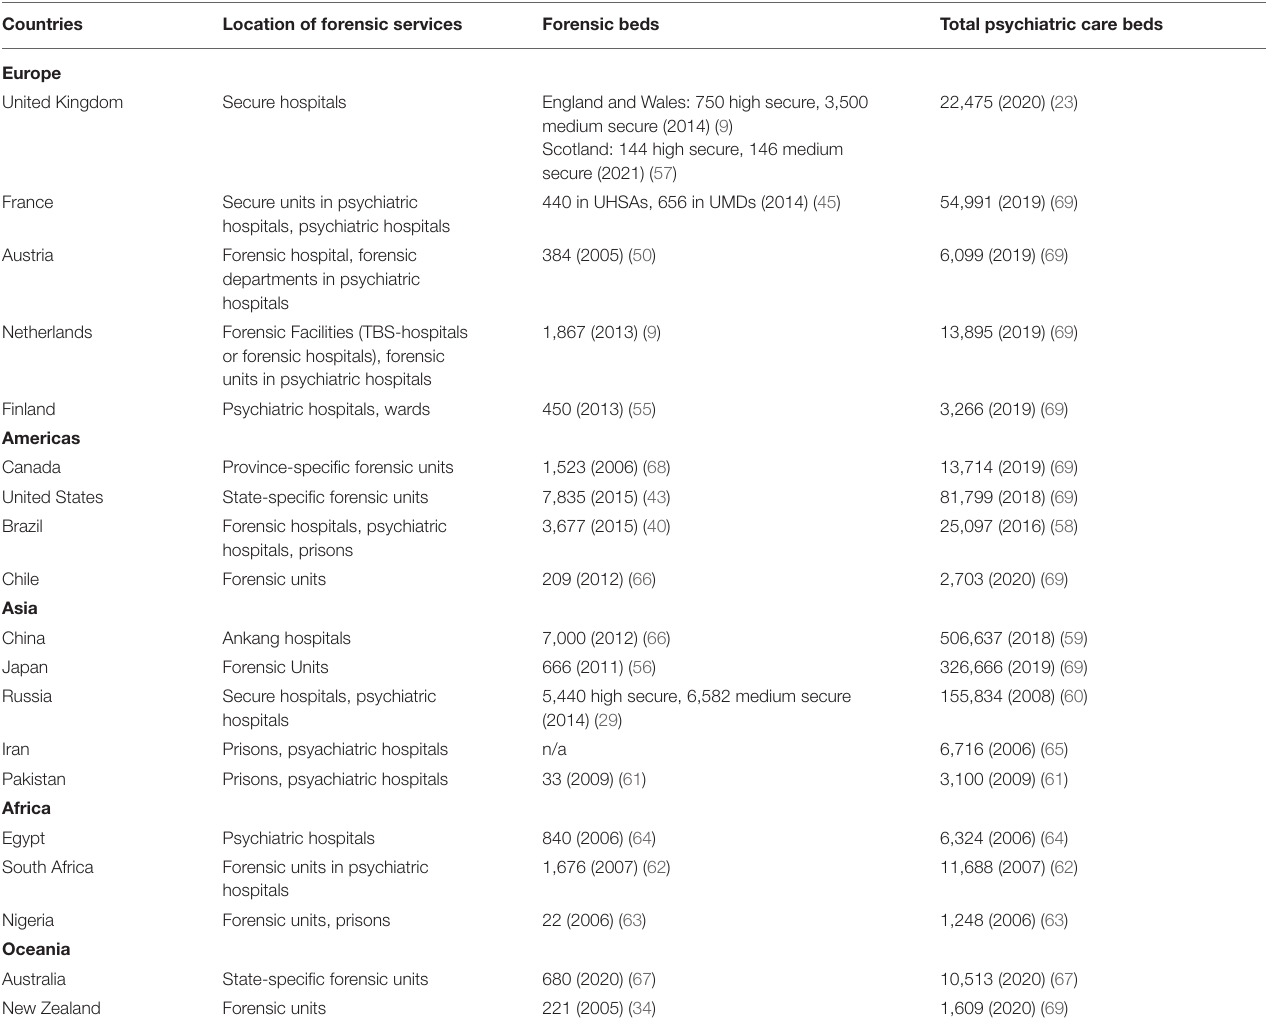
TABLE 2 | Forensic service and total number of psychiatric beds in countries mentioned in the results.